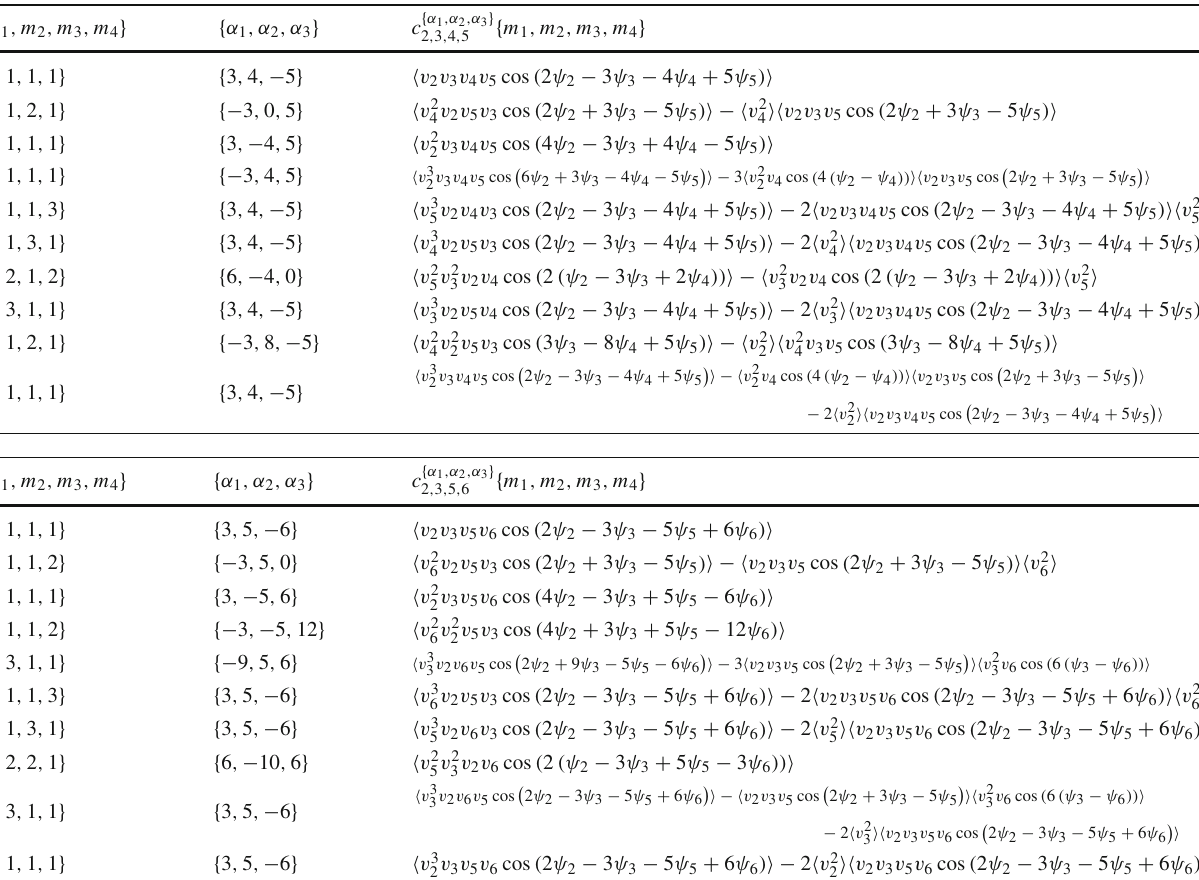
Table 6 Four-harmonic cumulants up to order